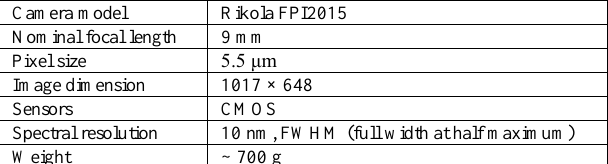
Table 1. Technical features.